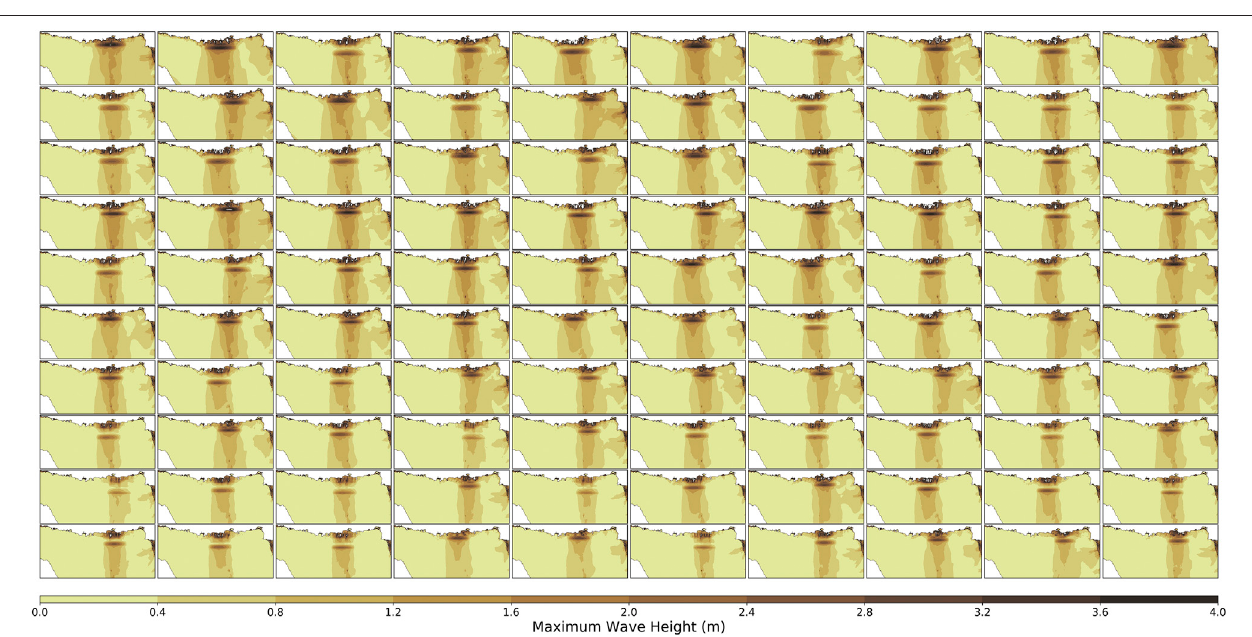
FIGURE 7 | Maximum wave heights ( η max ) resulting from Volna-OP2 simulations corresponding to the 100 training source deformations shown in Figure 4 .